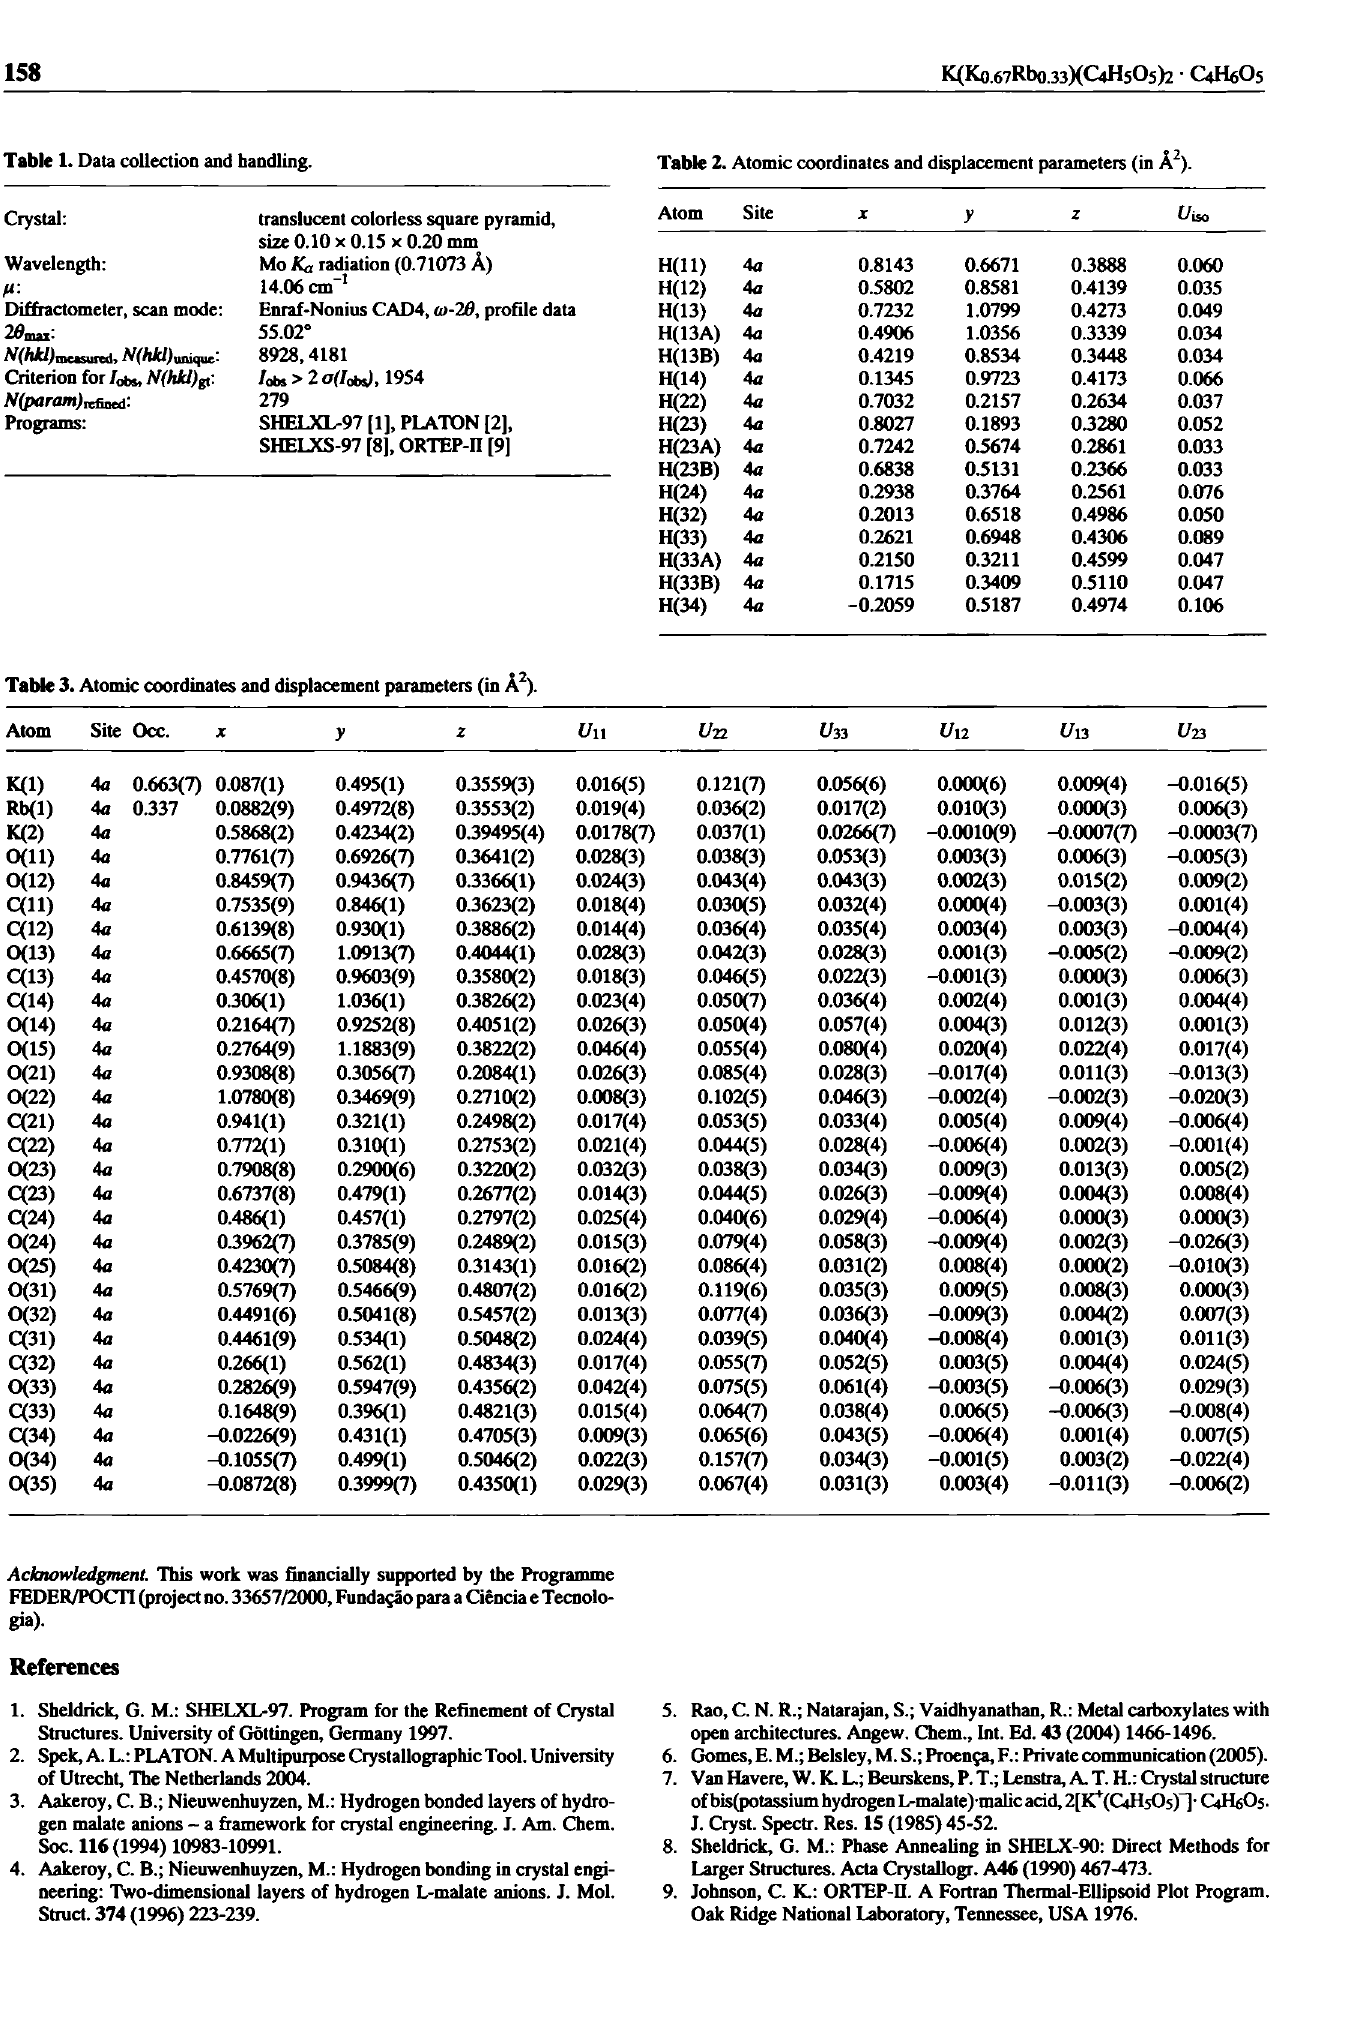
Table 3. Atomic coordinates and displacement parameters (in Ä 2